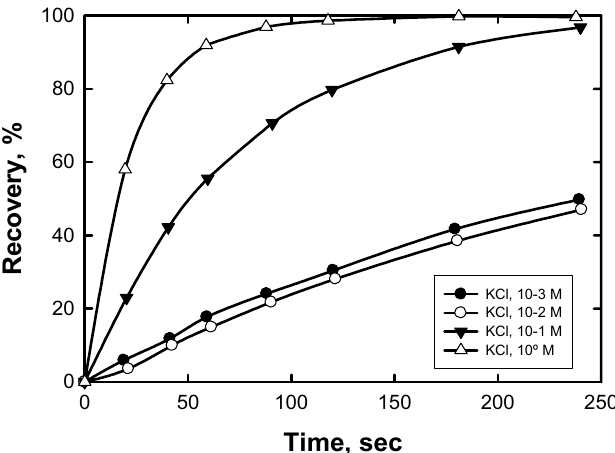
Fig. 3 The effect of KCl concentration on flotation of the methylated quartz particles ( θ= 53 (cid:155) ) at pH 6.1 to 6.5 (after Laskowski et al., 1991) 8) .